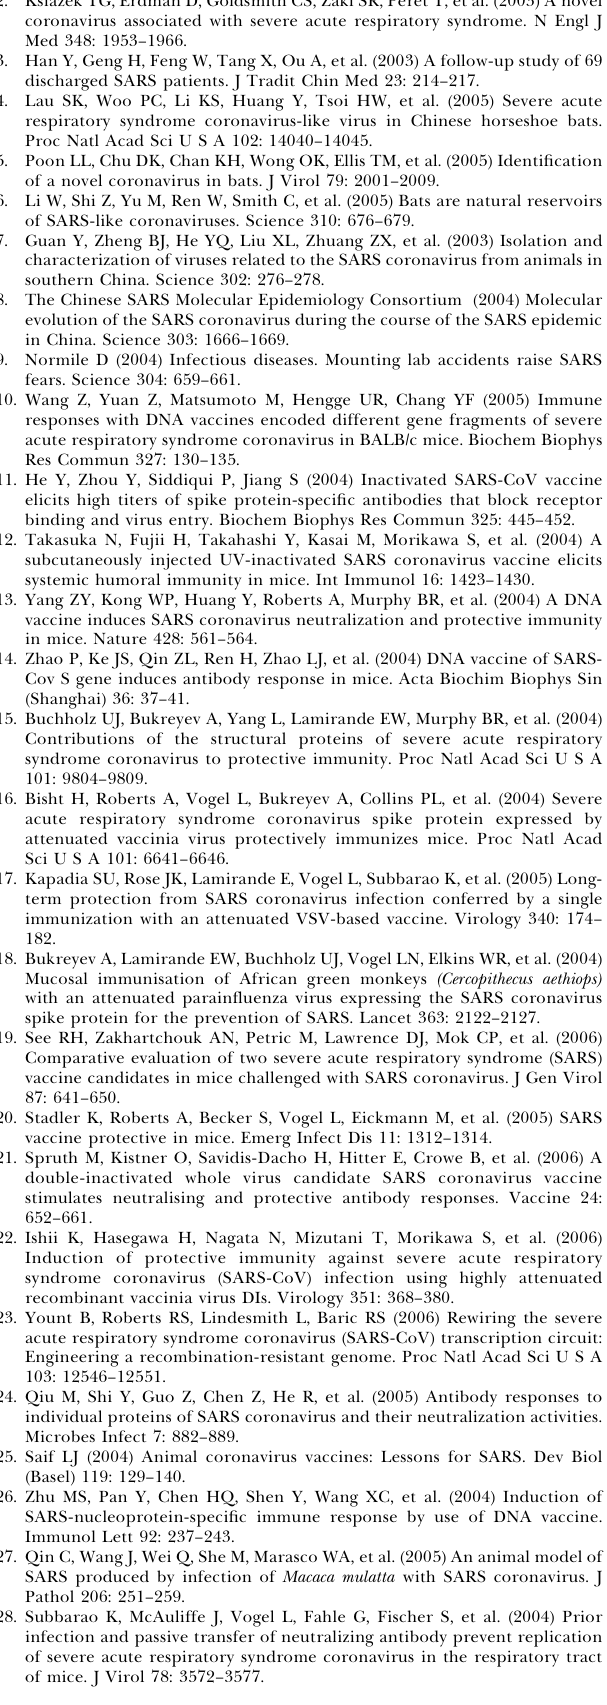
Table S1. Titers and PRNT 80 Dilutions for Individual Senescent Mice Found at doi:10.1371/journal.pmed.0030525.st001 (146 KB